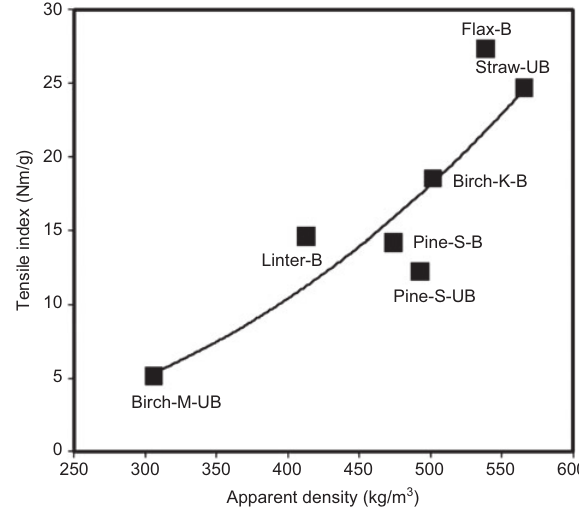
Figure 4 Denser sheets showed higher tensile index values.